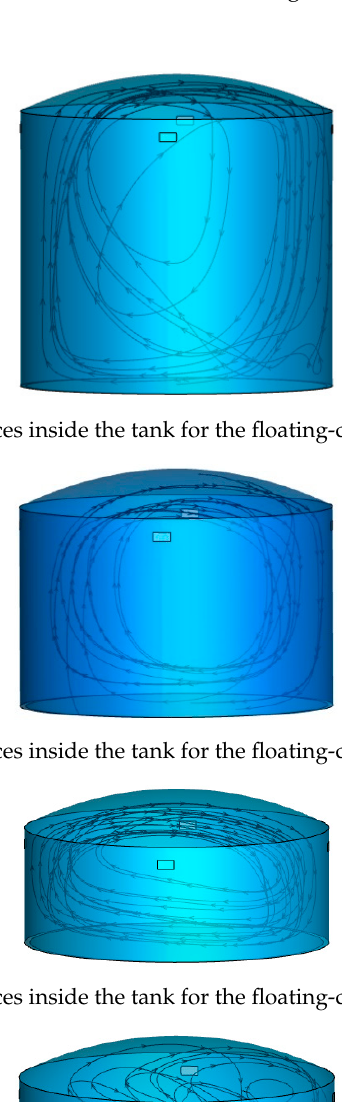
Figure 7. Streamtraces inside the tank for the floating-deck height of 8.45 m. Figure 8. Streamtraces inside the tank for the floating-deck height of 9.98 m.